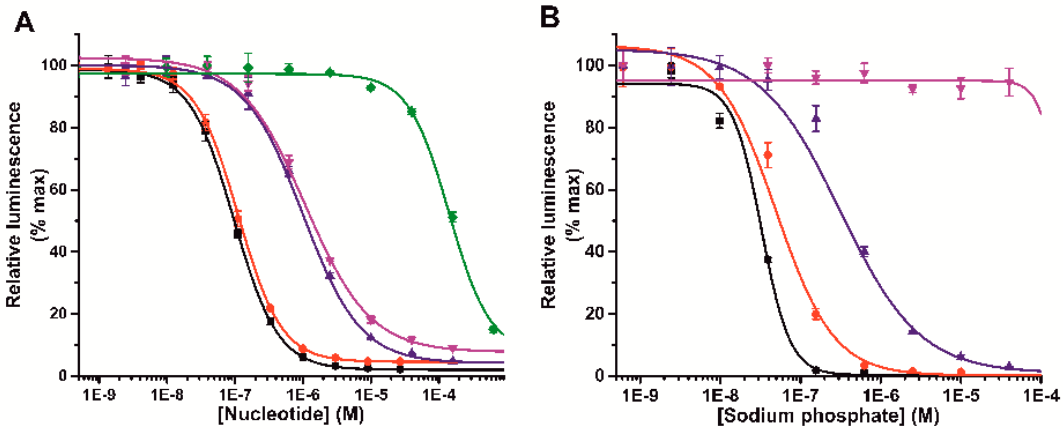
Figure 2. Time-gated Tb(III)-luminescence response curves of Probe 1 with different phosphate- containing molecules. ( A ) Probe 1 showed nanomolar nucleotide triphosphate detection sensitivity (GTP; black and ATP; red) and 10- to 1000-fold specificity over nucleotide di- and monophosphates (GDP; blue, ADP; magenta, and GMP; green), respectively. ( B ) Probe 1 detects sodium polyphosphates in similar phosphate number order as nucleotides, (NaPO 3 ) n (black) > (NaPO 3 ) 3 (red) > (NaPO 3 ) 2 (blue) >> Na 2 HPO 4 (magenta). Data represent mean ± SD (n = 3).